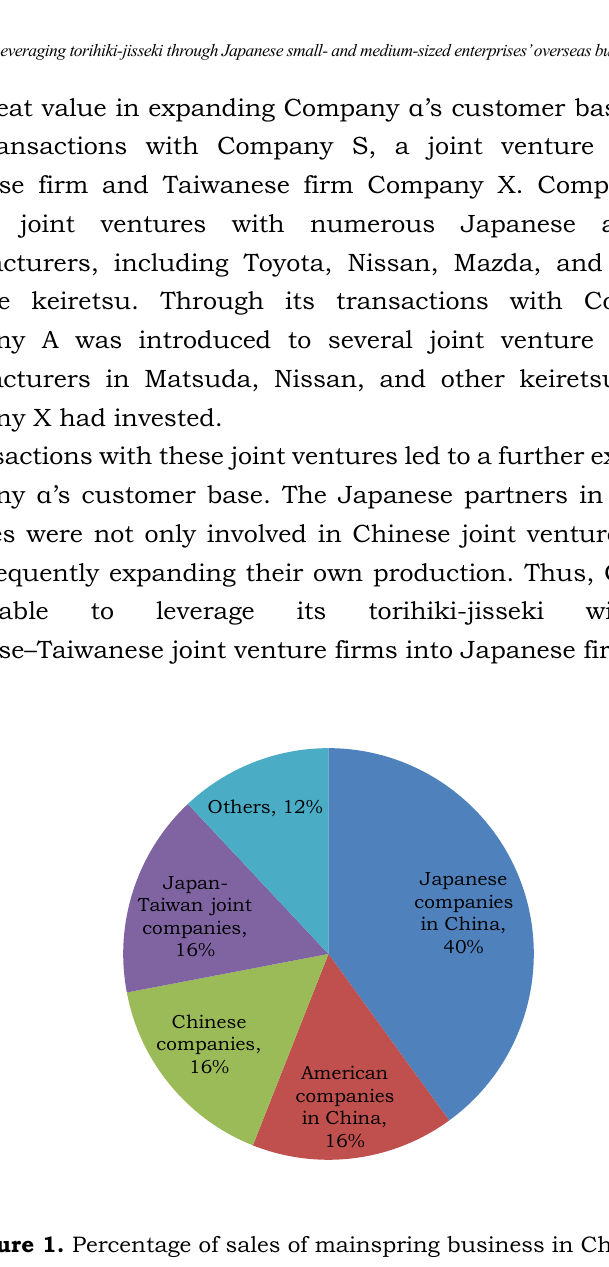
Figure 1. Percentage of sales of mainspring business in China (2011) Source: Company A presentation